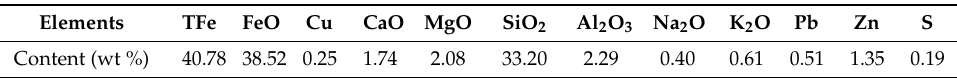
Table 1. Chemical composition of discarded copper slag.